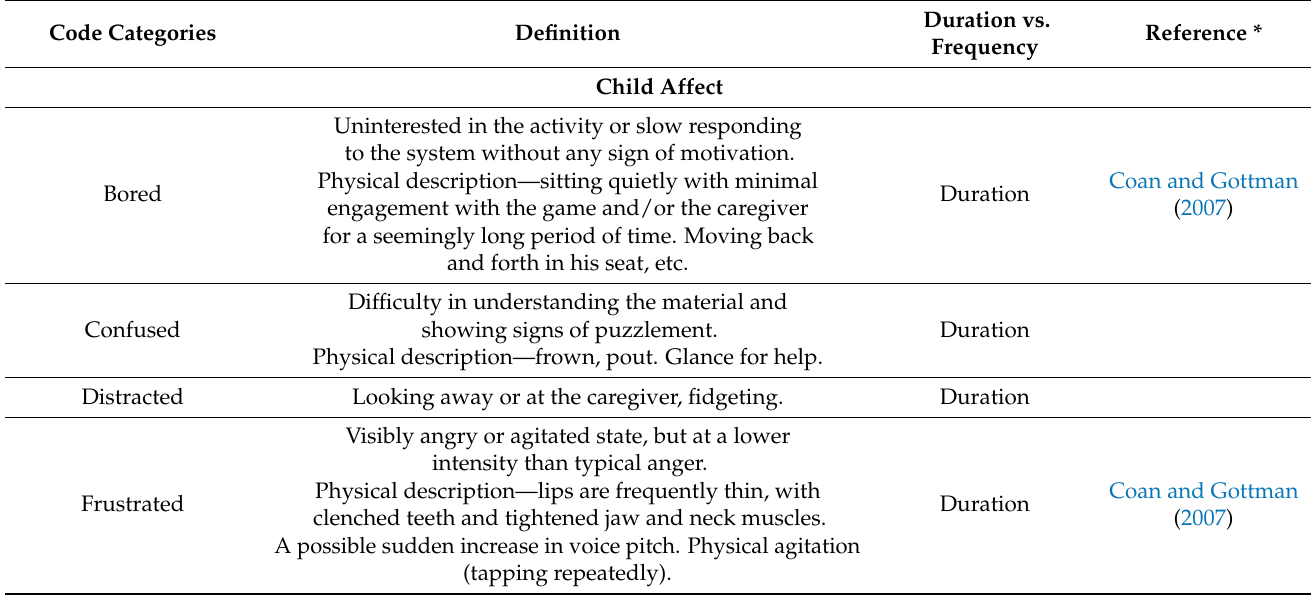
Table 1. Child coding rubric of behavior, affect, verbalization, and iPad manipulation